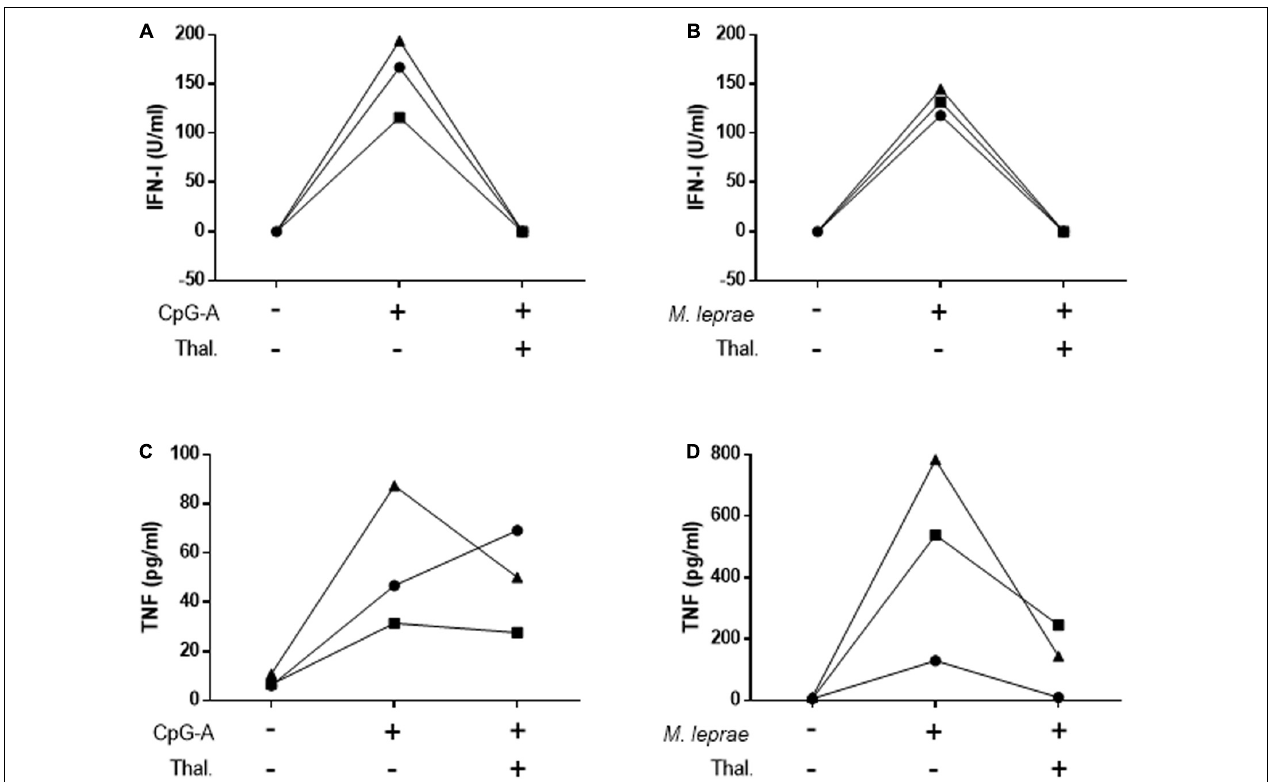
FIGURE 4 | Thalidomide blocks CpG- and M. leprae -induced IFN-I secretion by PBMCs. Quantification of IFN-I (A,B) and TNF (C,D) levels in culture supernatants of PBMCs from three healthy donors stimulated with 0.5 µ M CpG-A (A,C) or 20 µ g/mL M. leprae sonicate (B,D) and treated or not with 50 µ g/mL thalidomide for 24 h. Each individual is represented by a different